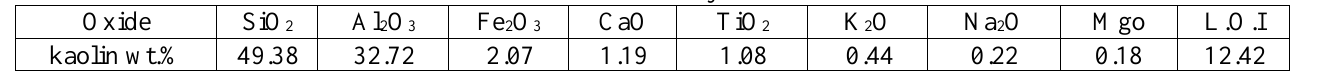
Table 1: Chemical analysis of kaolin.